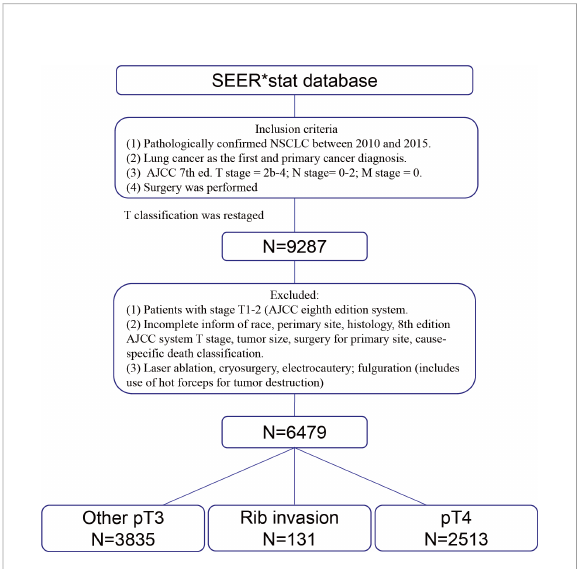
FIGURE 1 Schematic presentation of case selection. SEER, Surveillance, epidemiology, and end results. NSCLC, Non-small cell lung cancer. AJCC, American Joint Committee on